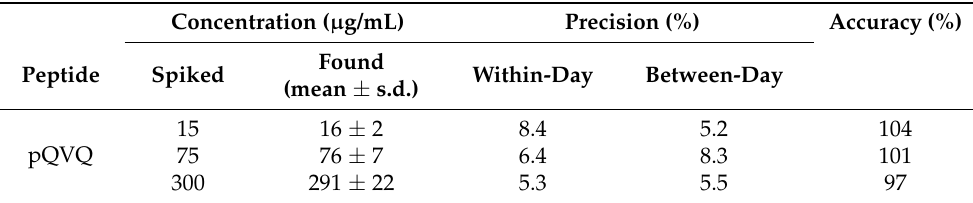
Table 6. Assessment of accuracy and precision for rituximab in plasma using the LC-MS/MS method and pQVQ as surrogate peptides ( n = 3, ten days). Concentration ( µ g/mL) Precision (%) Accuracy (%) Found Peptide Spiked (mean ± s.d.)